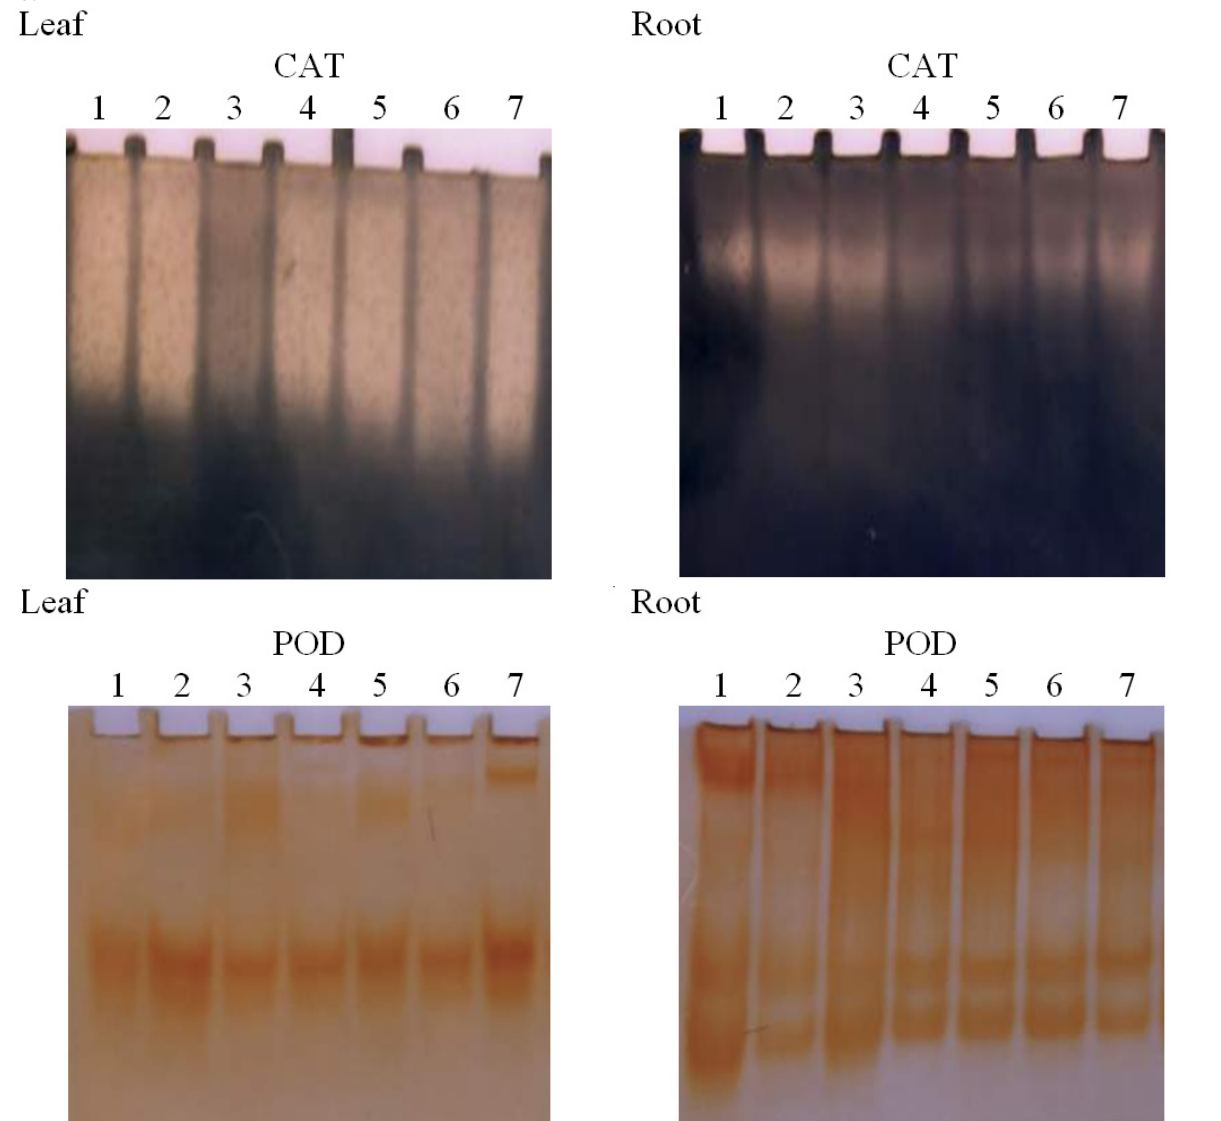
Fig. 3. Catalase and peroxidase isoenzyme patterns of radish tissues (leaves and roots) at harvest time (40 days growth) in plants grown in Cd containing